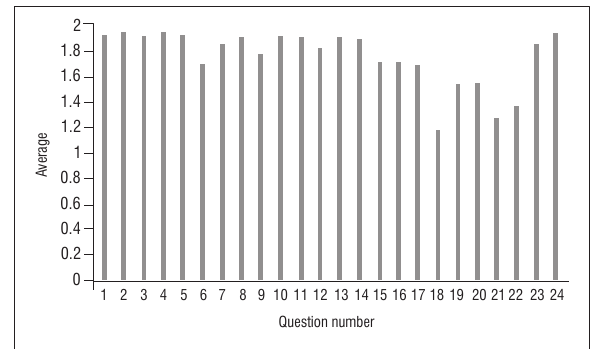
Figure 3: Average student scores for each question ( n =997).